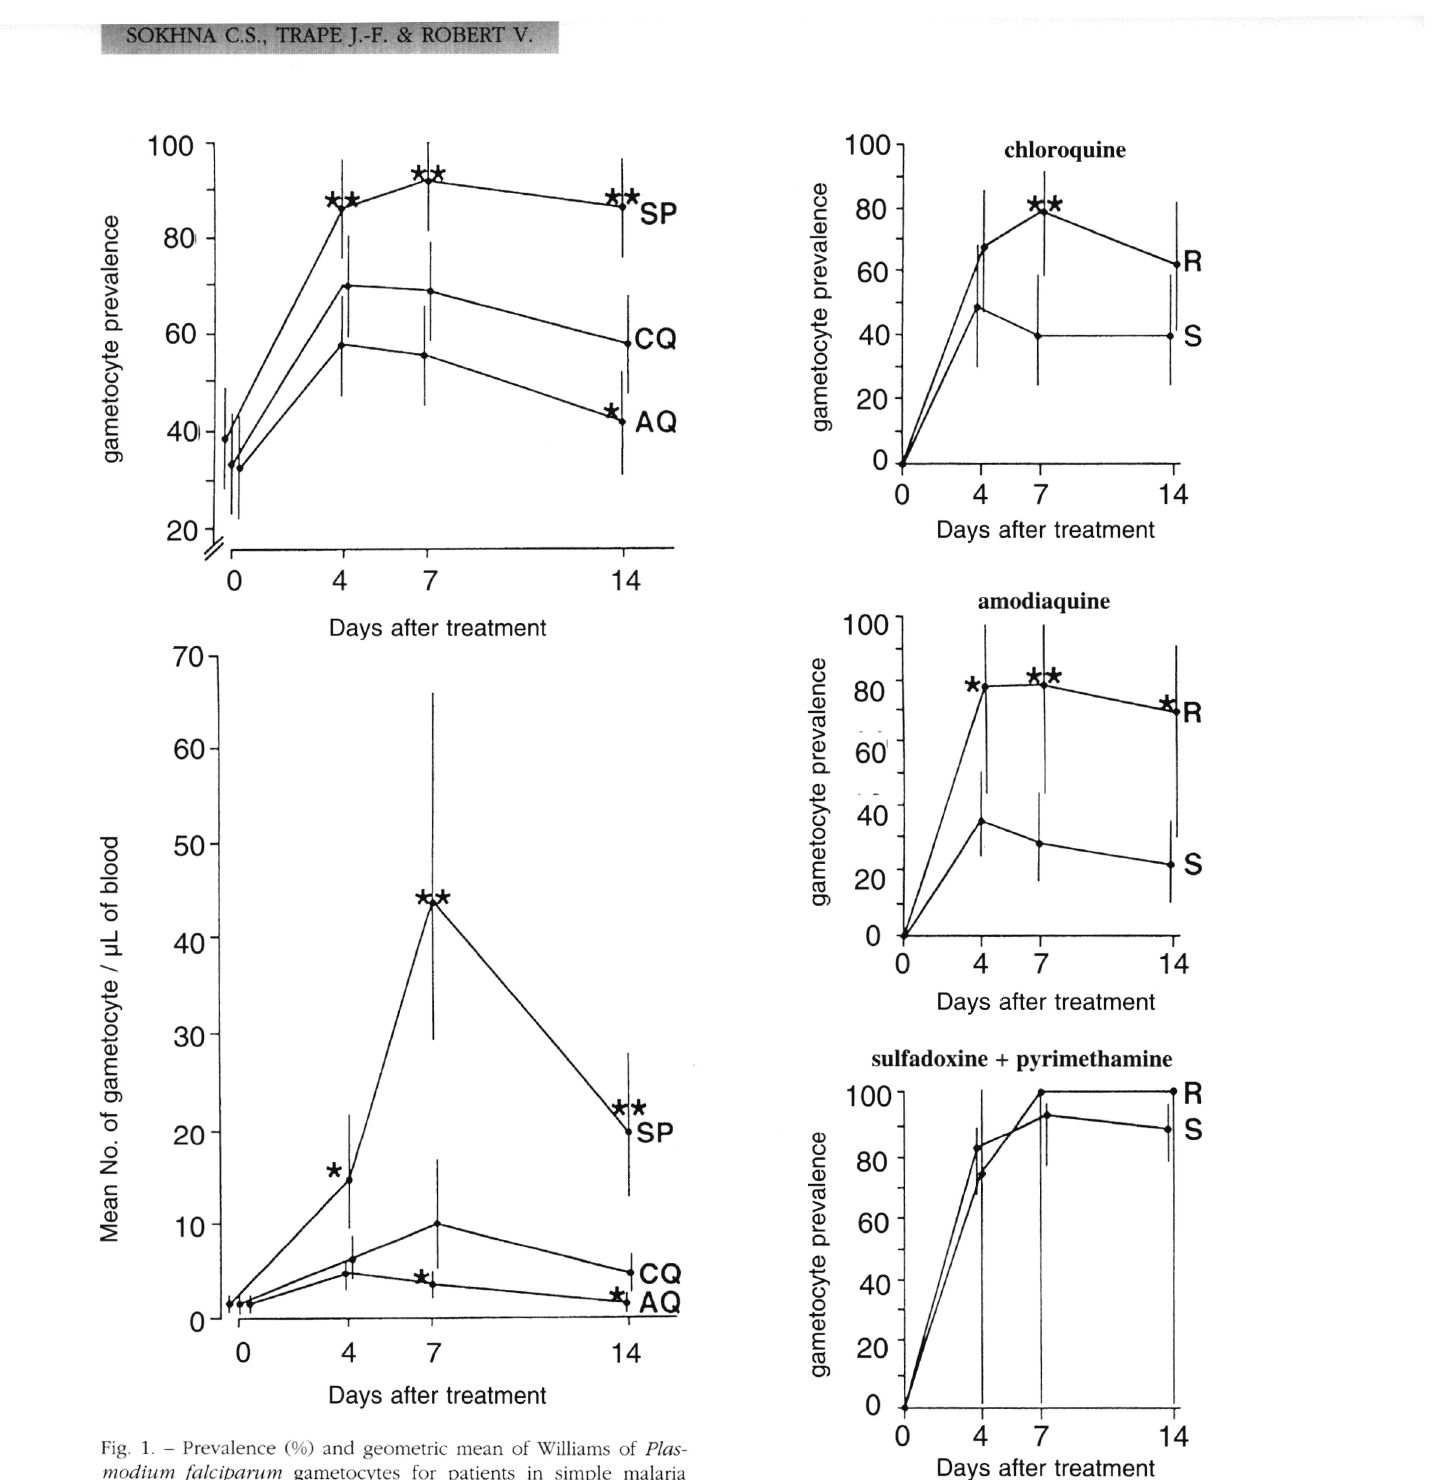
Fig. 2. - Prevalence of P. falciparum gametocytes for patients in simple malaria access, without gametocytes at day 0, treated with different drugs (57 patients with chloroquine, 58 patients with amo­ diaquine, and 58 patients with sulfadoxine plus pyrimethamine). Above spots of resistant (R) infections, one asterisk indicates a P value < 0.05 and two asterisks indicate a P value < 0.005, by com­ paring against sensitive (S) infections on the same day with Fisher’s exact test. Bars indicate the 95 % confidence interval.